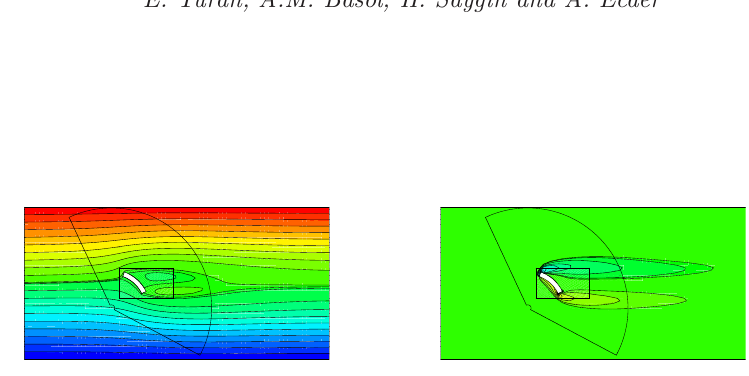
Figure 11. Stream function and vorticity for Re = 160 and α = 42 o .